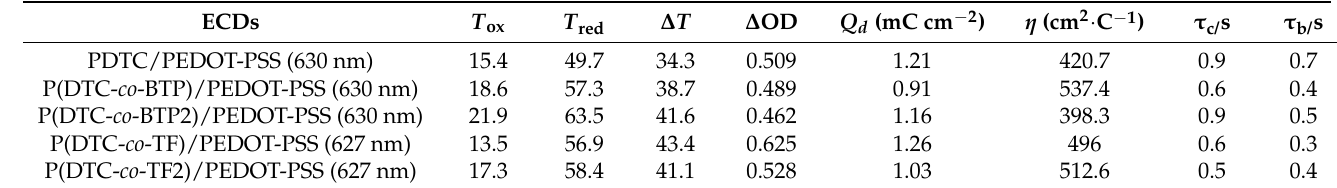
Table 6. Optical properties of